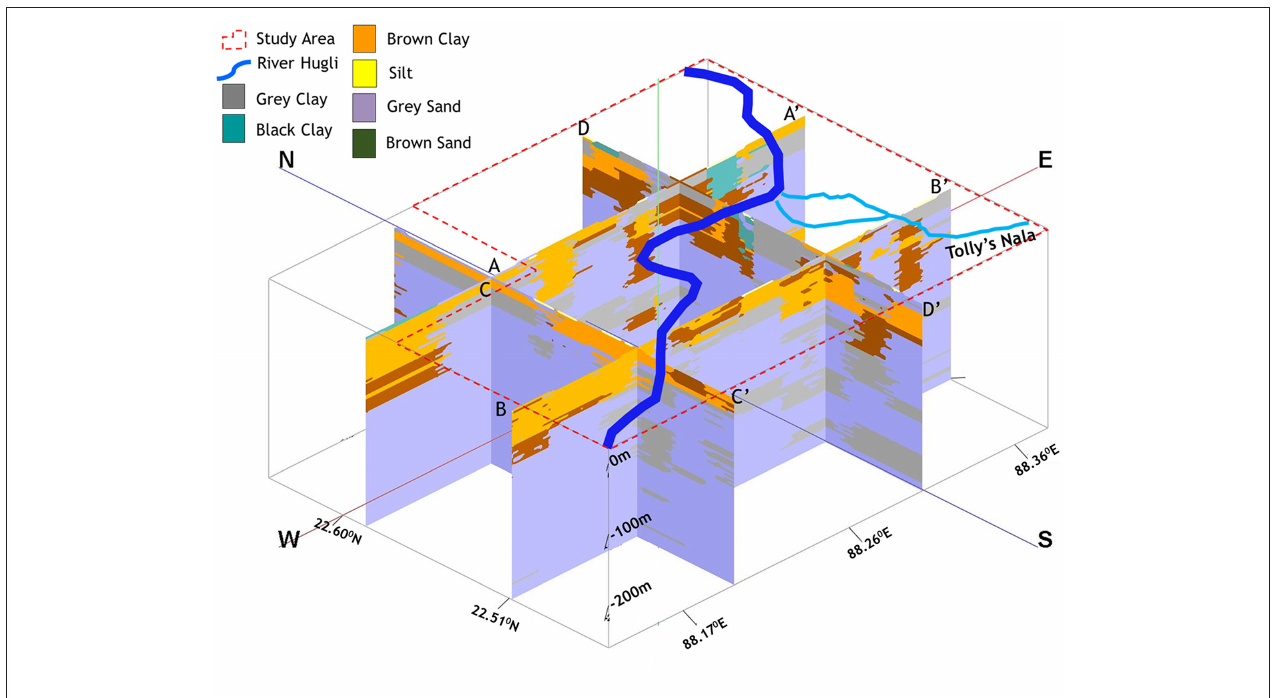
FIGURE 2 | Three-dimensional subsurface geological sections of the area marked in Figure 1 . The palaeo-channel Tolly’s Nala (Adi Ganga), a previous course of the River Hugli, is also represented on the 3-D model (modified after Banerjee and Sikdar,